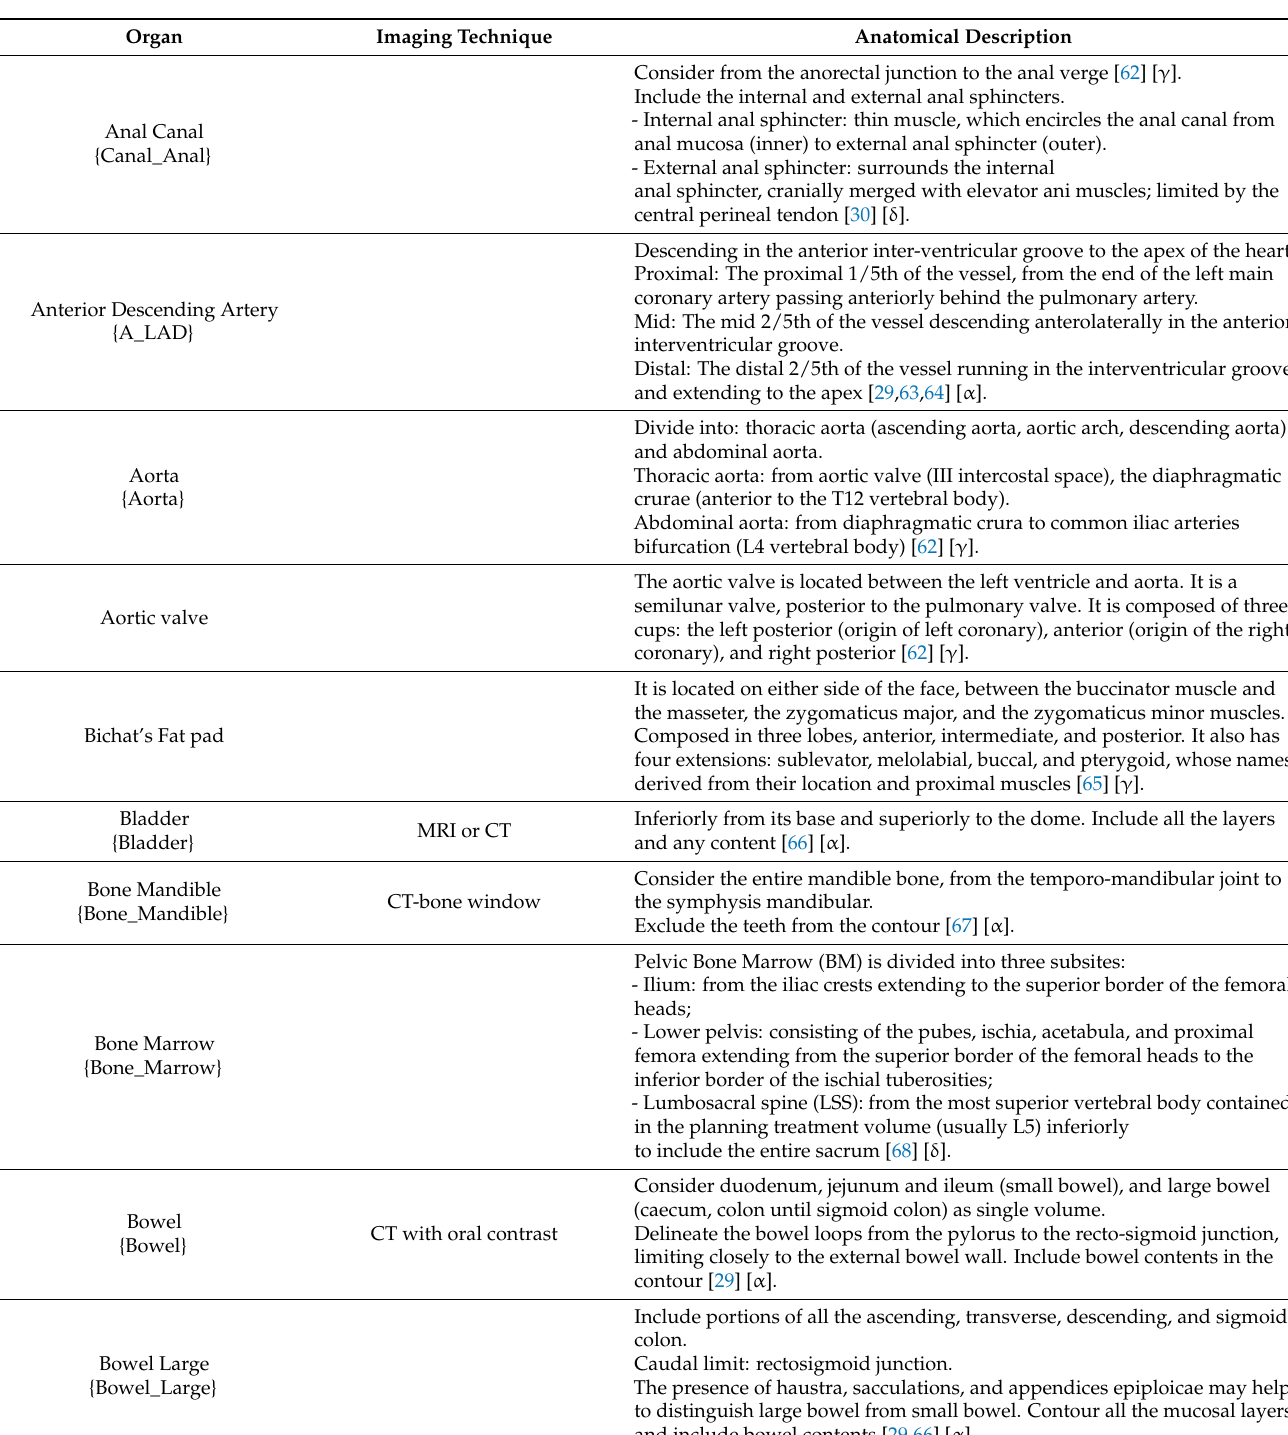
Table 2. Anatomical description of organs at risk (organ nomenclature based on the Global Quality Assurance of Radiation Therapy Clinical Trials Harmonization Group (GHG) contouring guidelines